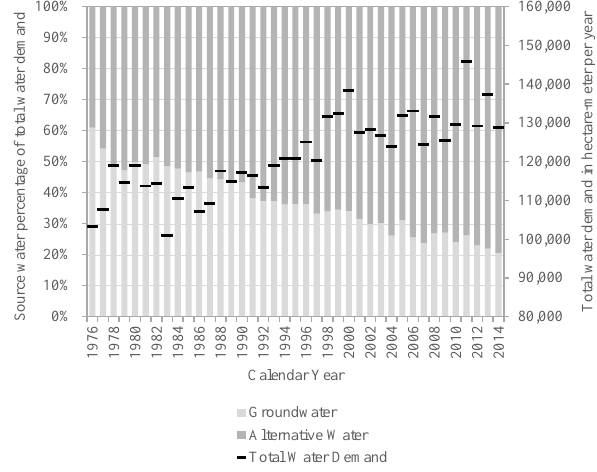
Figure 1. Groundwater and alternative source water percentage and total water demand, 1976–2014, Harris-Galveston Subsidence Dis- trict, Texas, USA.